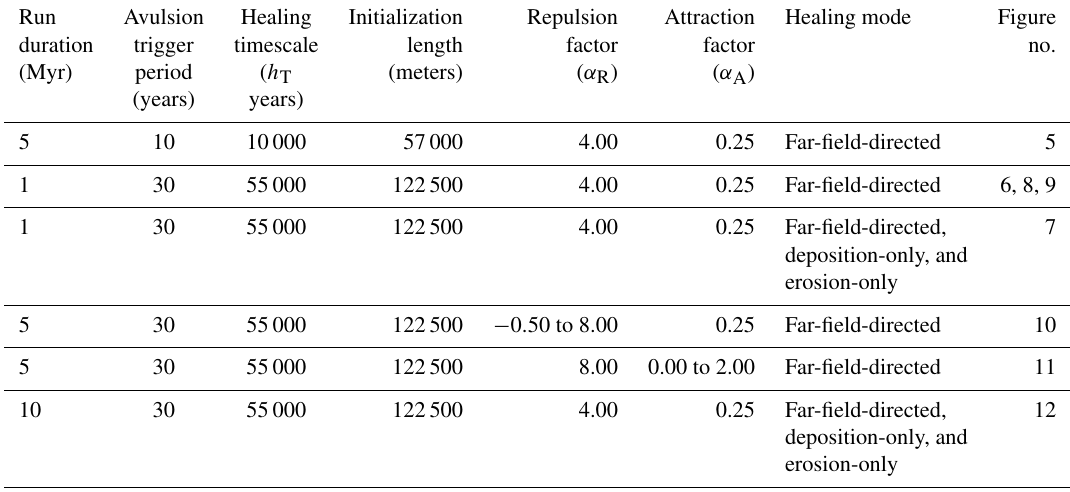
Table 3. Model parameters used to generate figures. Run Avulsion Healing Initialization Repulsion Attraction Healing mode Figure duration trigger timescale length factor factor no. (Myr) period ( h T (meters) ( α R ) ( α A ) (years) years) 10 10000 0.25